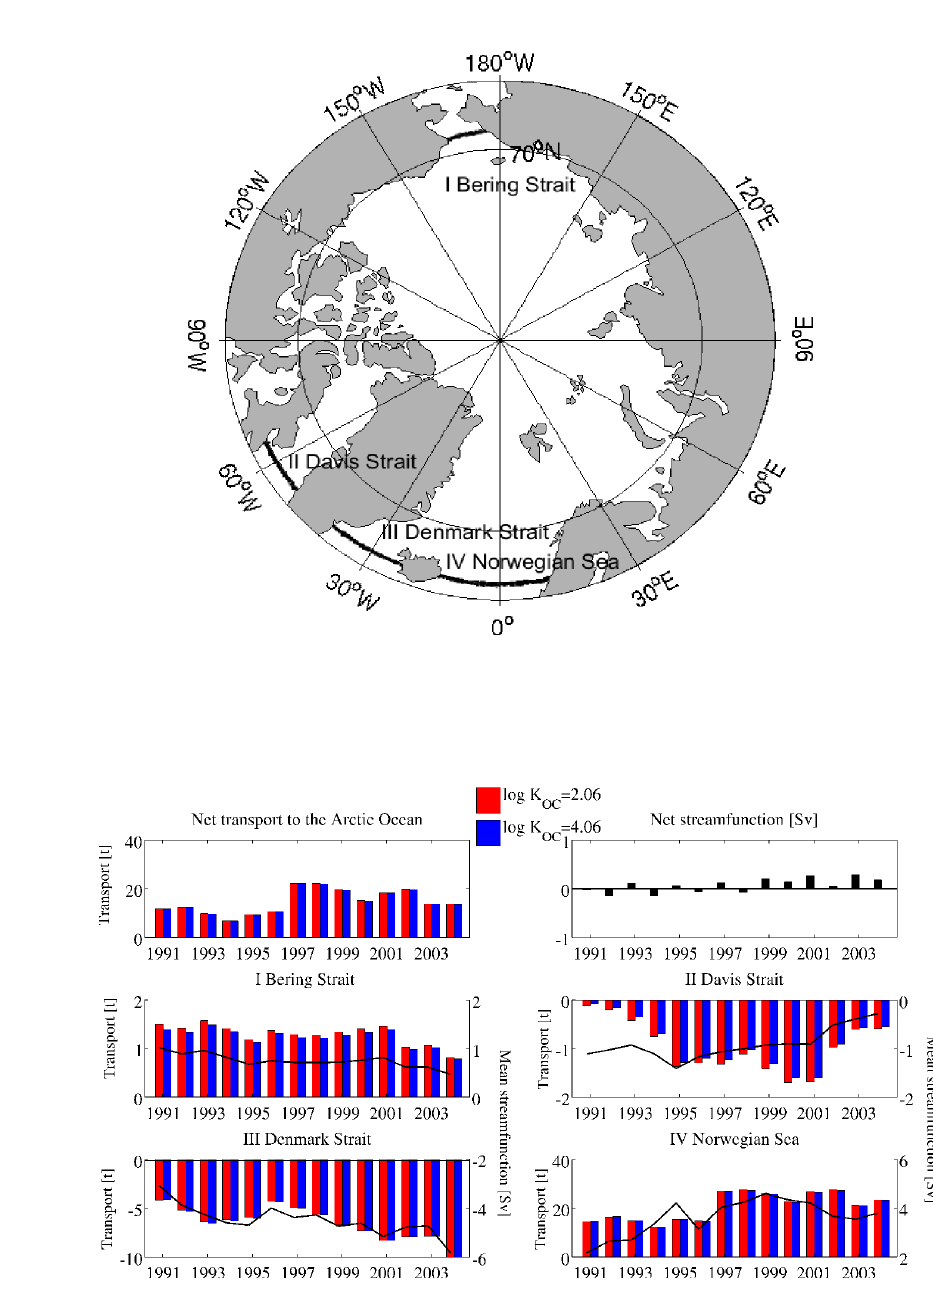
Fig. 9. Time series of annual transports [t a − 1 ] of PFOA (two substance scenarios) into the Arctic ocean and annual mean stream functions [Sv], (a) locations of 4 cross sections surrounding the Arctic ocean, (b) total and individual contributions through these cross sections. Bars denote PFOA transports, solid lines volume transports of water [Sv].